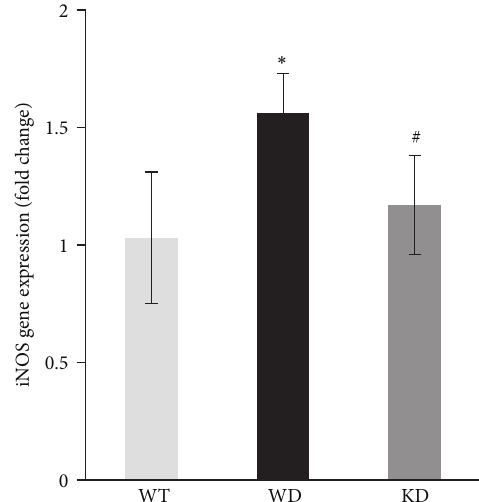
Figure 4: Diabetes does not alter retinal iNOS expression in the mouse lacking MMP-9. Gene expression of iNOS was quantified in the retina of wild-type (WT) mice and MMP-9 KO (KO) mice diabetic for 3 months by real-time quantitative PCR. The mRNA levels of the targeted proteins were adjusted to the levels of 𝛽 -actin in each sample. Results are expressed as mean ± s.d. of at least five to six mice in each group. ∗ 𝑃 < 0.05 compared with WT nondiabetic mice and # 𝑃 < 0.05 compared to WT diabetic mice. WT and WD = wild-type nondiabetic and diabetic, respectively, and KD = MMP-9 KO diabetic